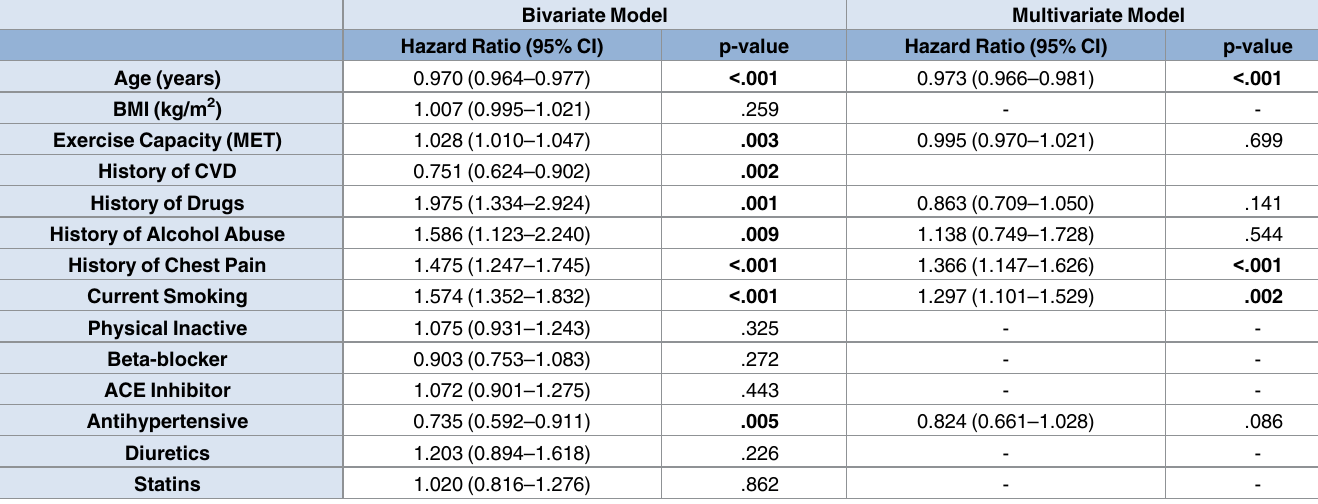
Table 2. Univariate and multivariate Cox proportional hazard analysis which were independently associated to PTSD in 5826